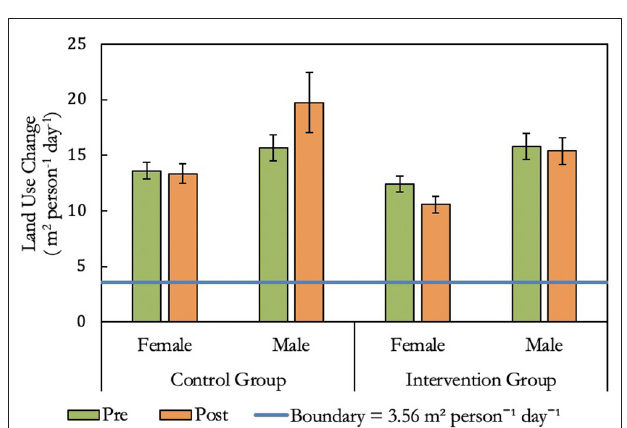
FIGURE 3 | Changes in dietary water use footprint from baseline to follow up for female and male students in the intervention and control group. The per capita food-related planetary boundary of 0.685 m 3 person − 1 day − 1 (for a population of 10 billion in 2050) is shown by the blue line.